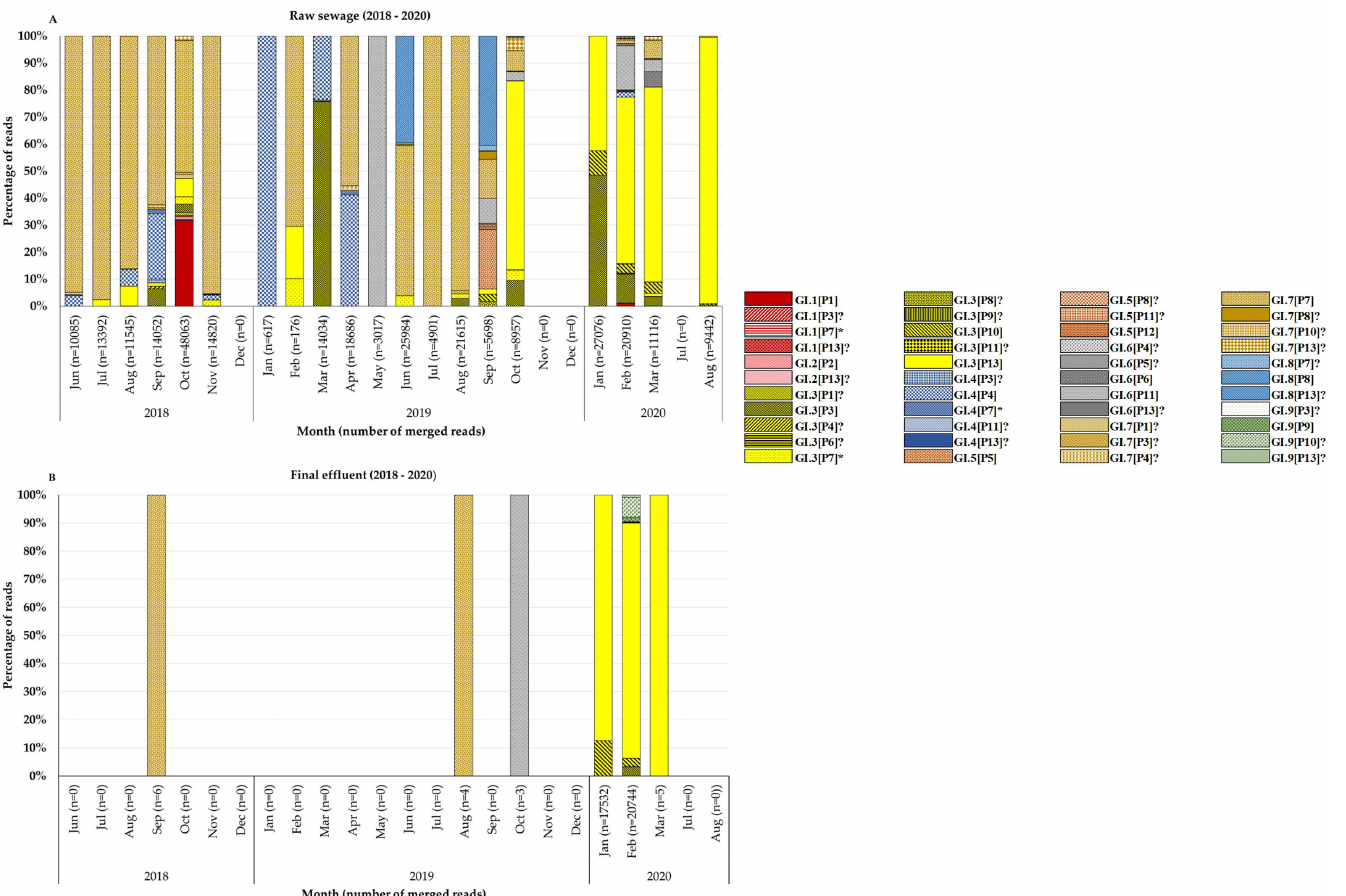
Figure 2. Norovirus GI molecular typing. Distribution and abundance of norovirus GI strains identified from ( A ) raw sewage and final effluent ( B ) samples between June 2018 and August 2020. The amplicons from different sampling sites were pooled equimolar based on wastewater sample type and month of collection. The numbers in parentheses indicate the number of merged reads for each month. The key shows known RdRp-capsid combinations, putative novel recombinants (?) and Sanger-sequencing confirmed novel recombinants